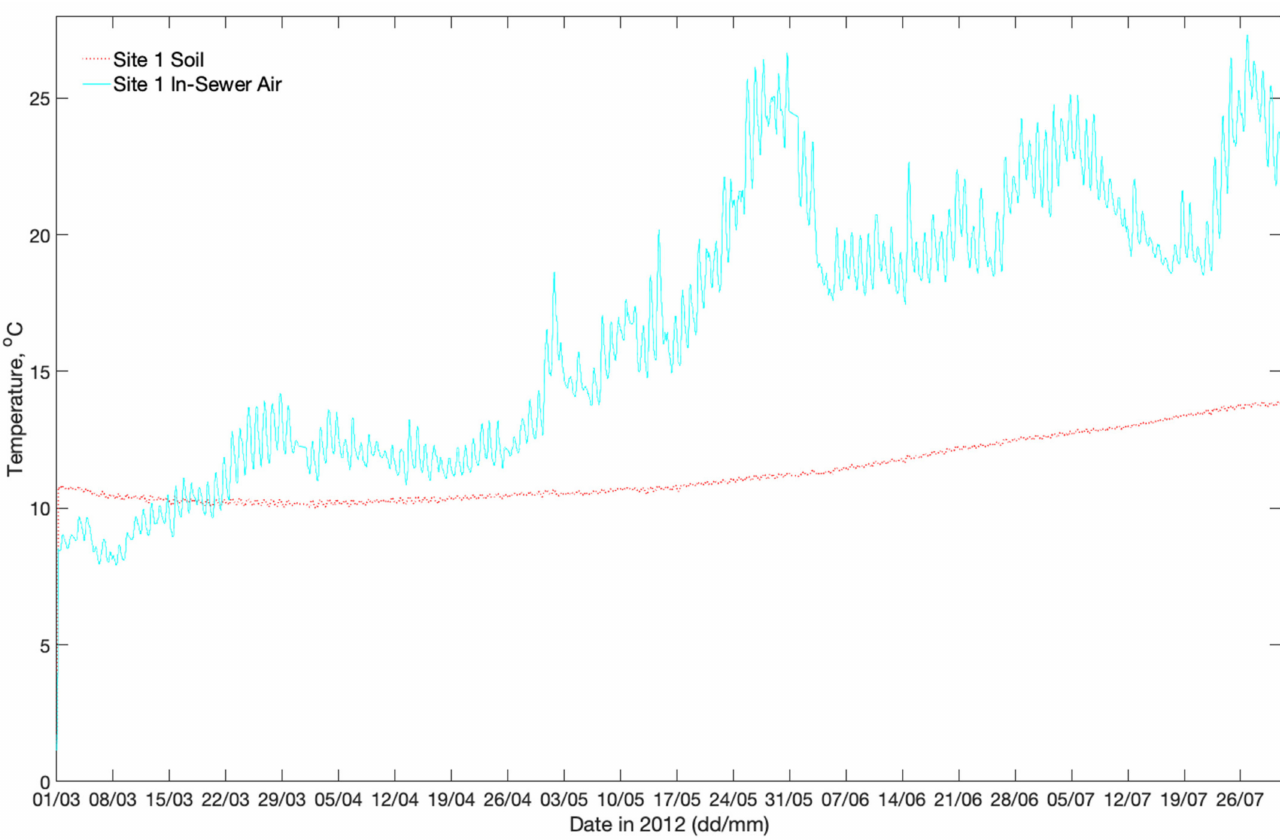
Figure 3. Temperature variations of soil and in-sewer air in a residential sewer (site 1). The pattern of observed in-sewer air temperature is very close to that of the wastewater temperatures at site 1 (Figure 1). Unlike soil temperatures, in-sewer air temperatures vary significantly during the day and increase considerably from winter to summer (Figure 3), which suggests that the diurnal wastewater temperature variation was less influenced by soil temperatures. This indicates that the temperature of in-sewer air largely affects that of wastewater. Therefore, the heat transfer process between wastewater and in-sewer air is thought to be important when modelling wastewater temperature in sewers over long durations. Figures 4 and 5 show the observed wastewater temperatures and flow rates for sites 3 and 4, respectively. Some technical issues related to data monitoring occurred between 7 and 21 June 2013 in site 4, hence the gap in Figure